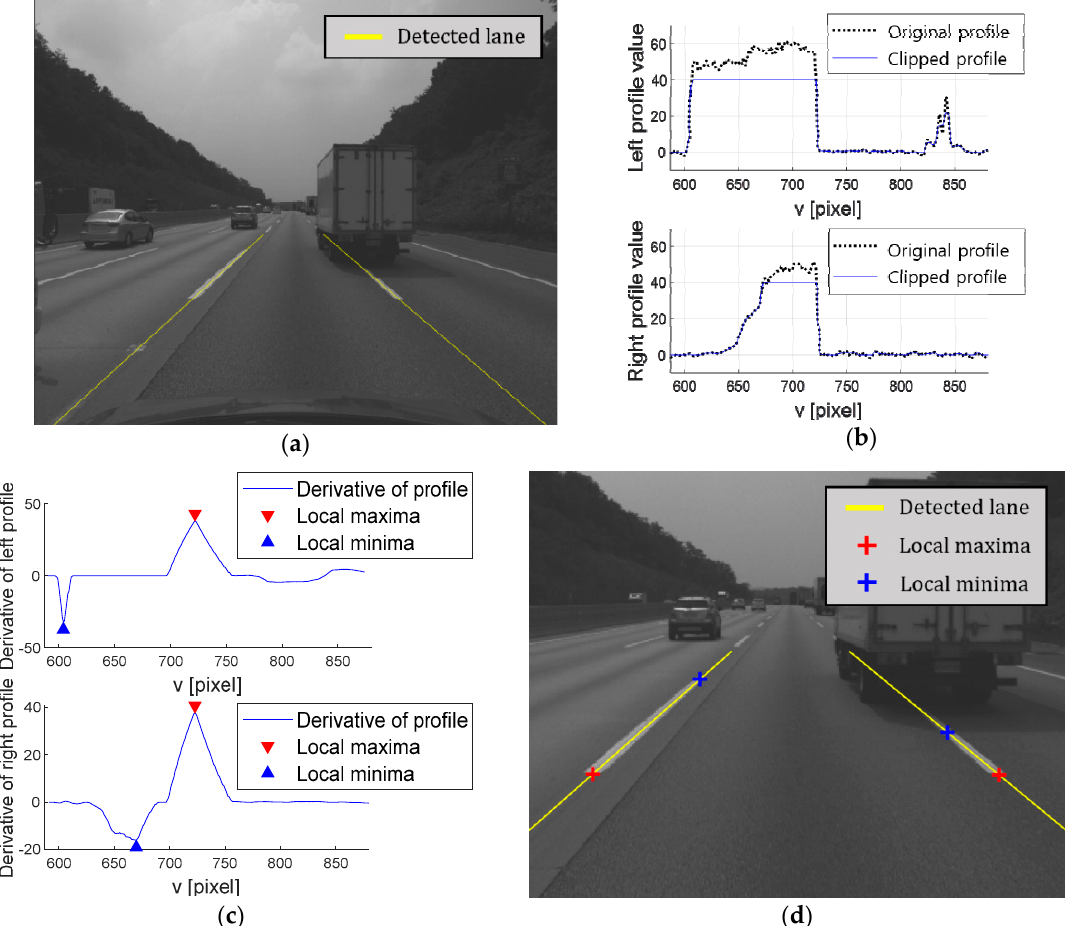
Figure 5. Lane endpoint candidate generation. ( a ) Lane detection result; ( b ) Left and right lane profiles; ( c ) Derivatives of the lane profiles and candidates of the lane starting and ending points; ( d ) Candidates of the lane starting and ending points in the image.